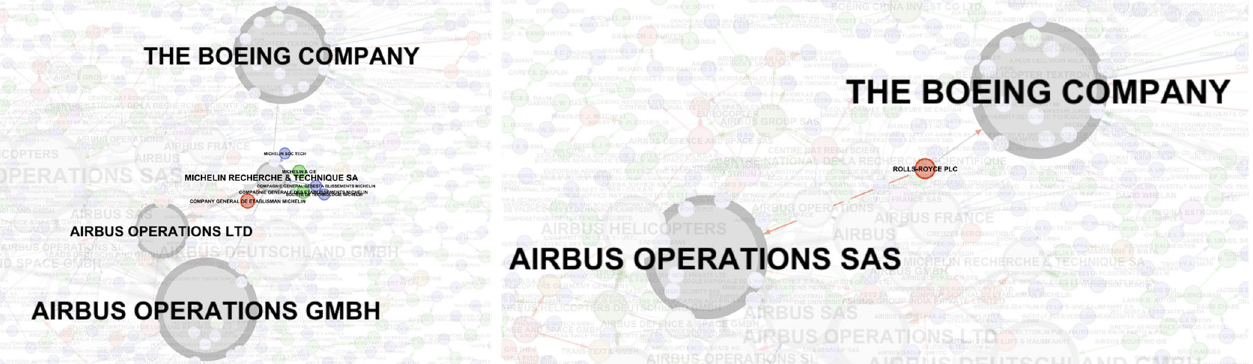
Figure 12. Network Analysis of Tech Broker.